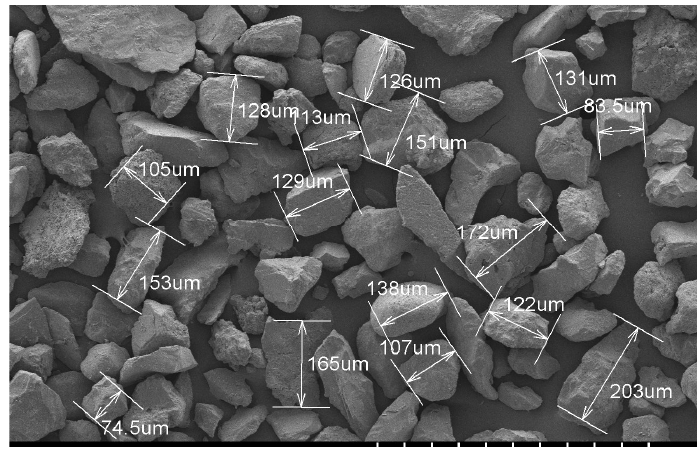
Figure 8. Scanning Electron Microscopy (SEM) of Saemangeum dredged sand.